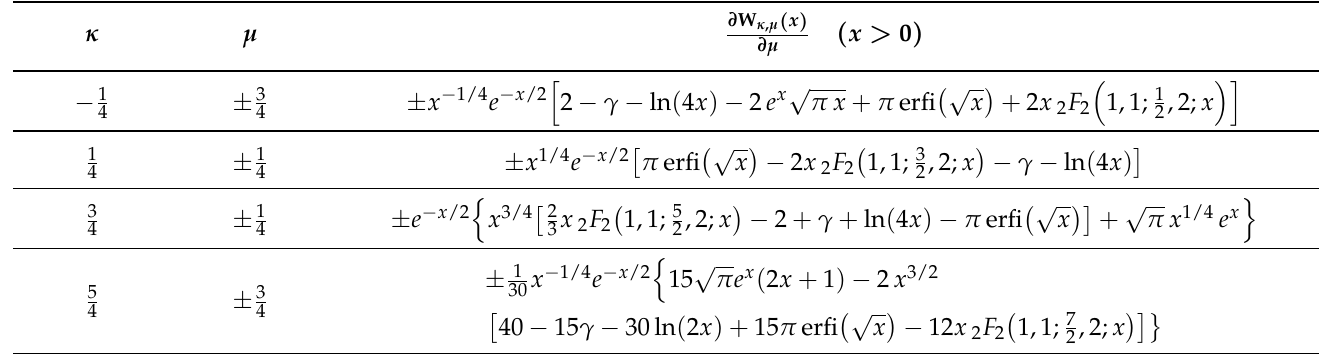
Table 7. Derivative of W κ , µ with respect to µ , by using